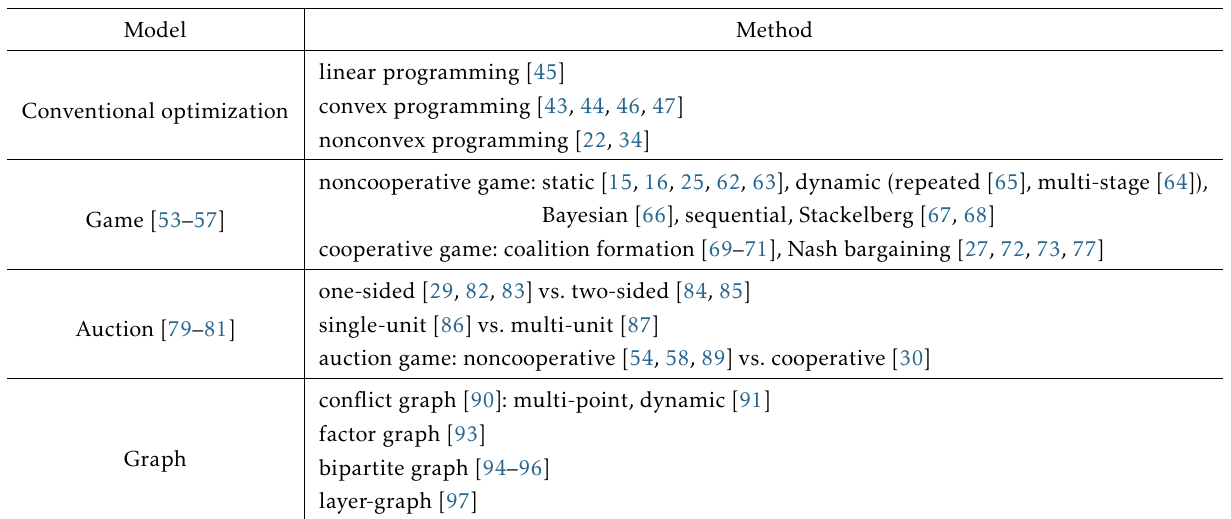
Table. 2. Models and methods for spectrum